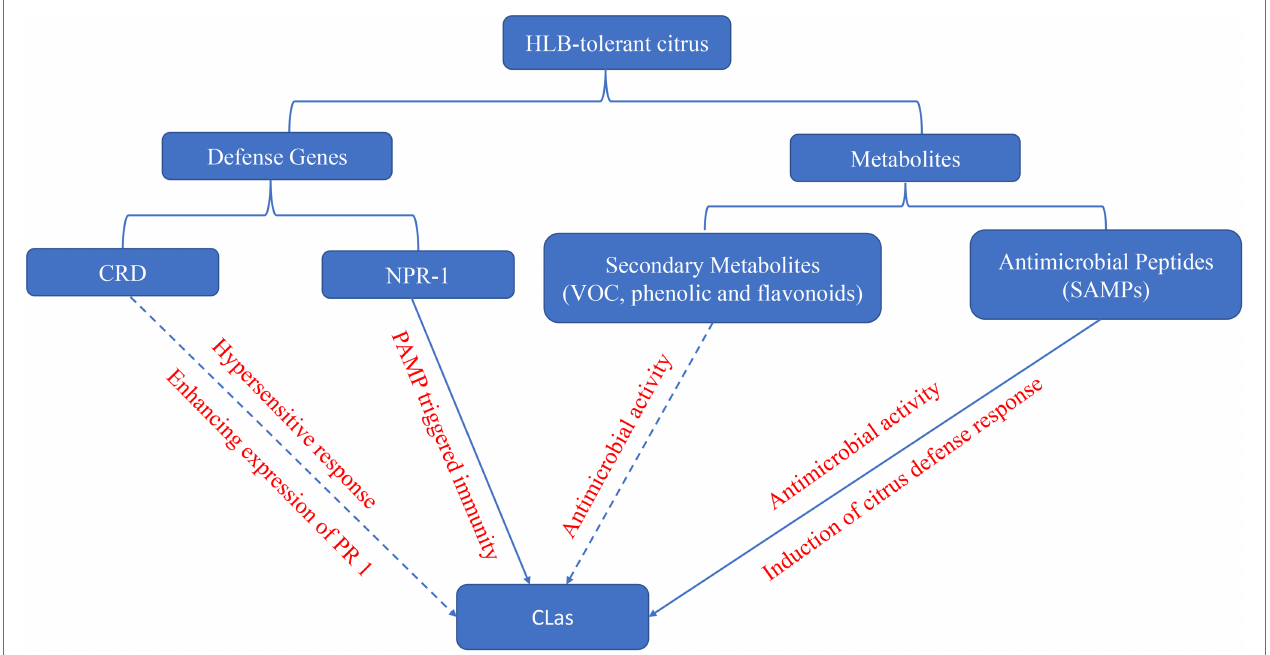
FIGURE 1 | The potential mechanism of defense genes and metabolites in HLB-tolerant citrus against C Las. Solid line indicates that the functions were confirmed in citrus, and dash line indicates that the function were just confirmed in other